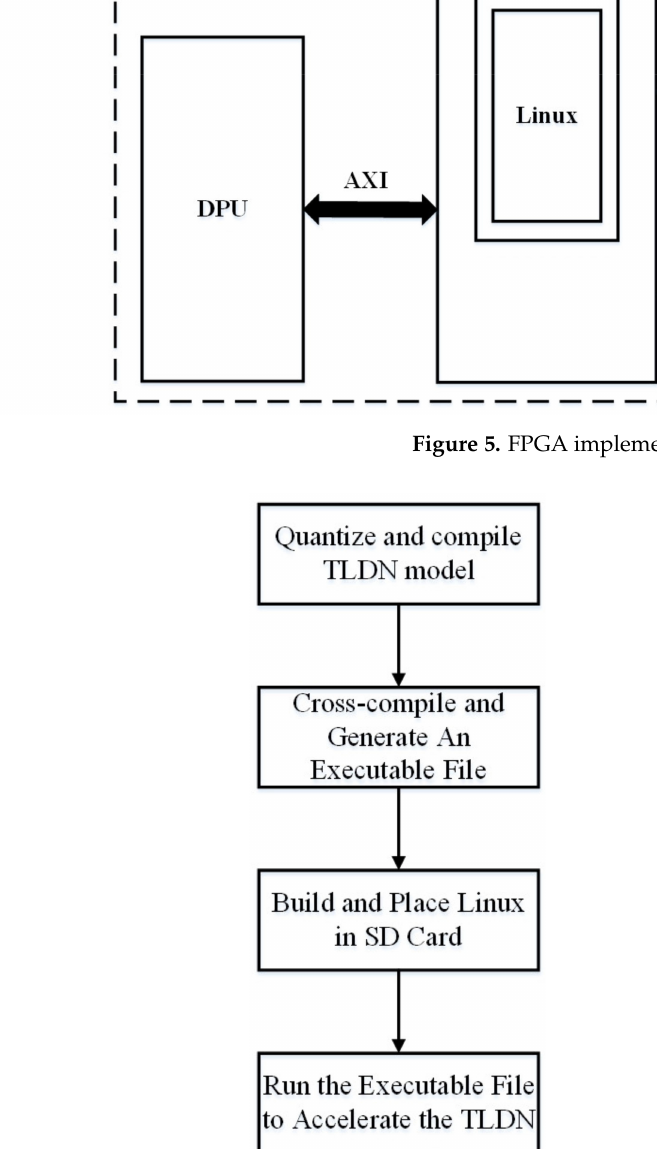
Figure 6. FPGA implementation